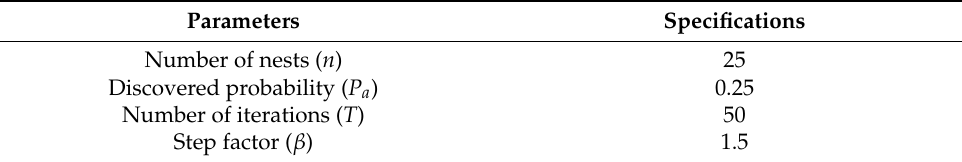
Table 2. Settings of parameters applied in the traditional cuckoo